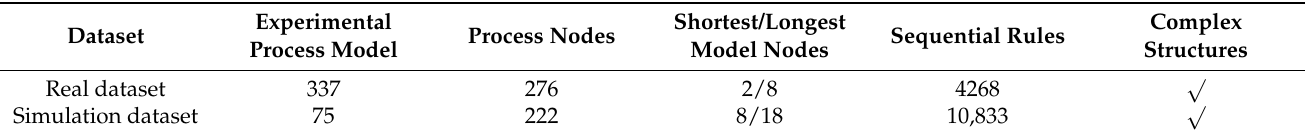
Table 3. Process